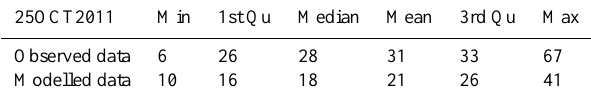
Table 4. Descriptive statistics of the observed and modelled 1h rainfall values for 25OCT2011 (unit is mm).